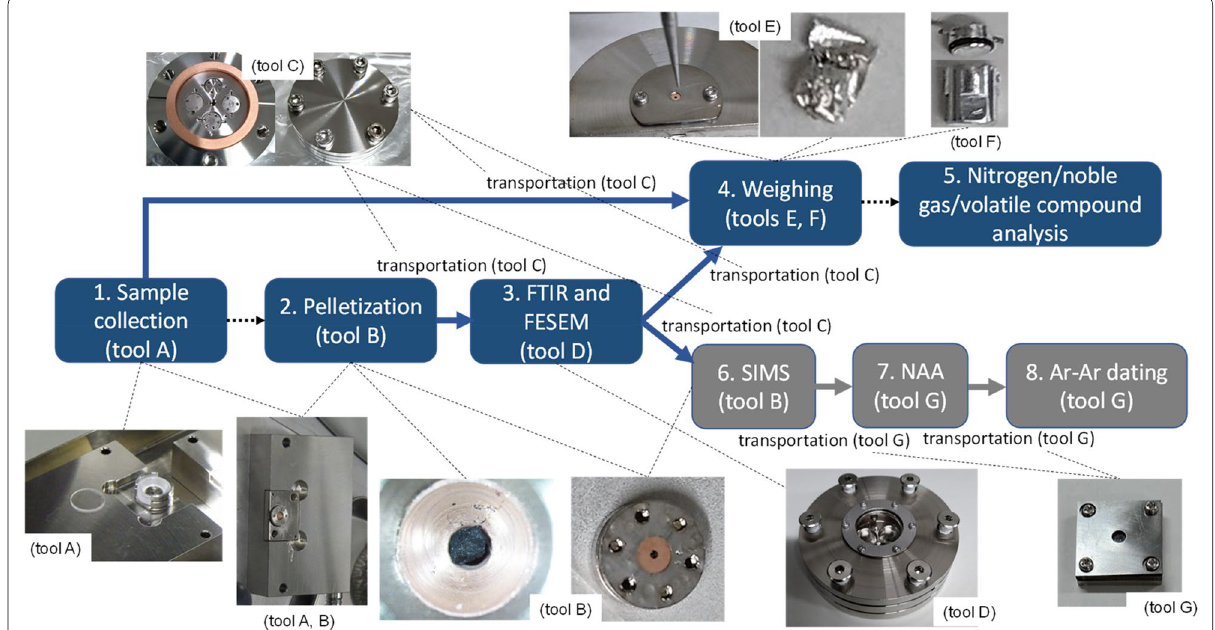
Fig. 1 Flow diagram of the volatile component analyses conducted by the Hayabusa2-Initial-Analysis Volatile sub-team. Operations 1–5 (blue boxes) were carried out without exposure to Earth’s atmosphere, whereas operations 6–8 were done in Earth’s atmosphere (gray boxes). The tools used in each operation are shown in the parentheses. The letters of the alphabet, tools “A–G”, correspond to those of the titles of subsections in the main text (e.g., “tool A” refers to subsection “(A) Sample handling